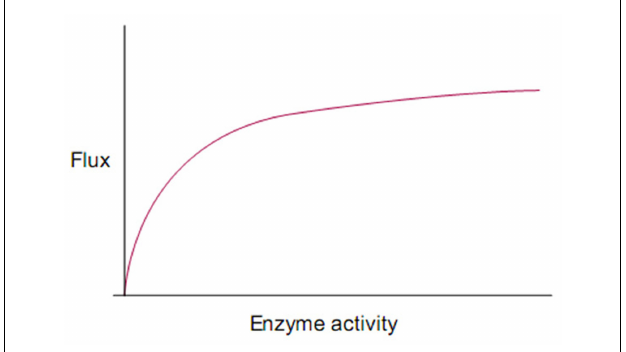
FIGURE 1 | Saturation kinetics: the hyperbolic relationship between enzyme activity and reaction